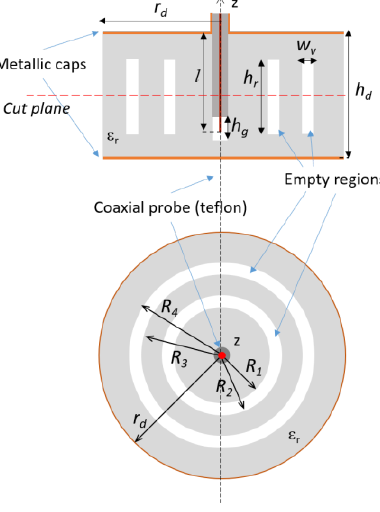
Figure 6. Lateral and top view of the third iteration of the design process in which an empty annular sector is introduced.